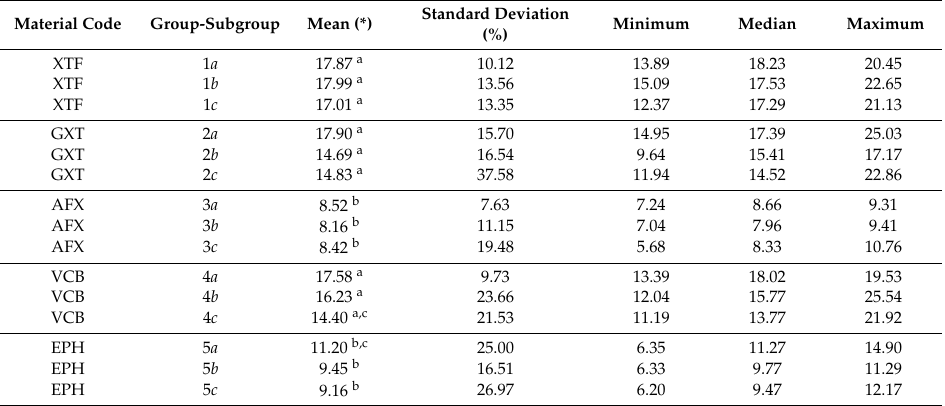
Table 3. Descriptive statistics of elastic modulus (MPa) for each group /